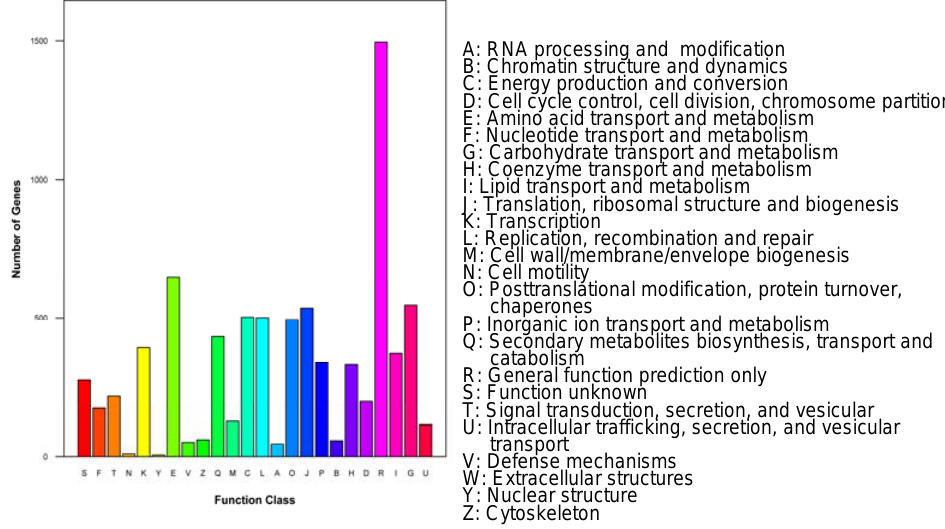
Figure 2. Histogram presentation of clusters of orthologous groups (COG) classification (7955 sequences have a COG classification among the 25 categories).